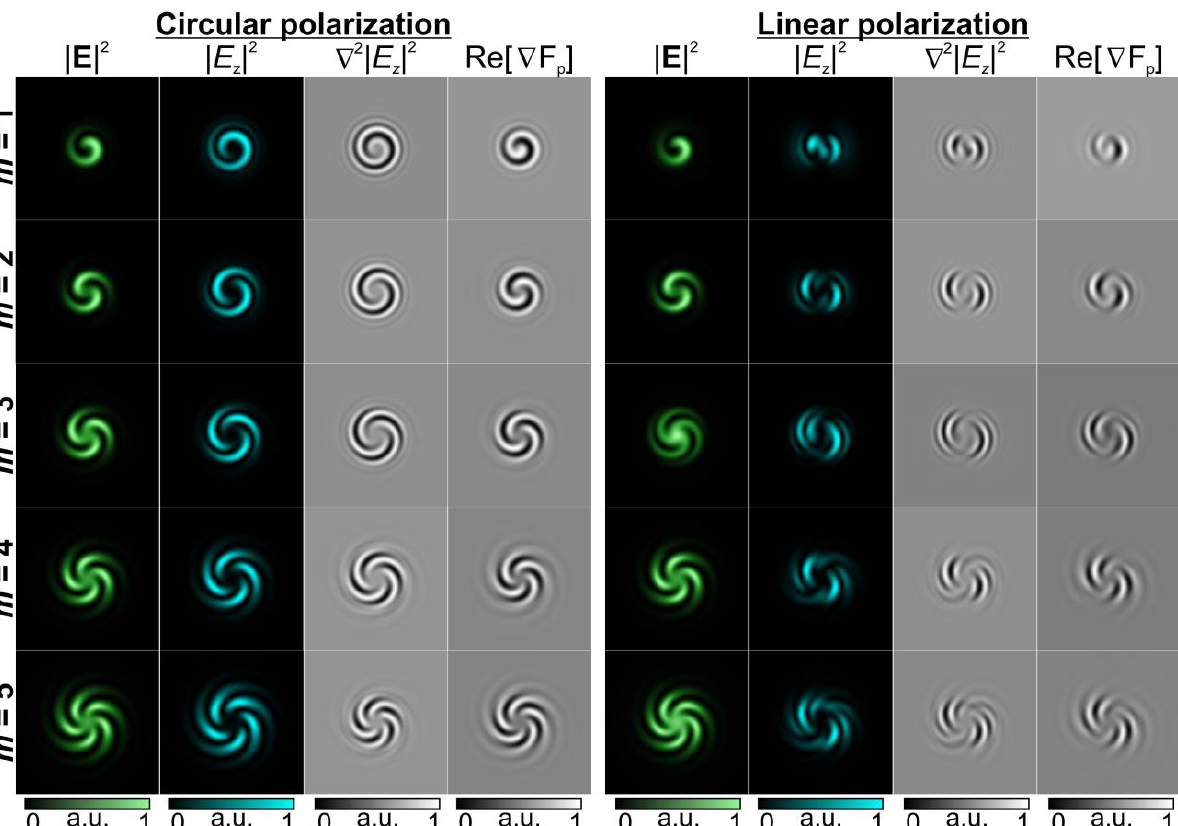
Figure 4. Numerically calculated characteristics of the light fields formed as a result of the interference of a Gaussian laser beam with a spherical wavefront and a circularly/linearly polarized OV beam with a non-zero TC.